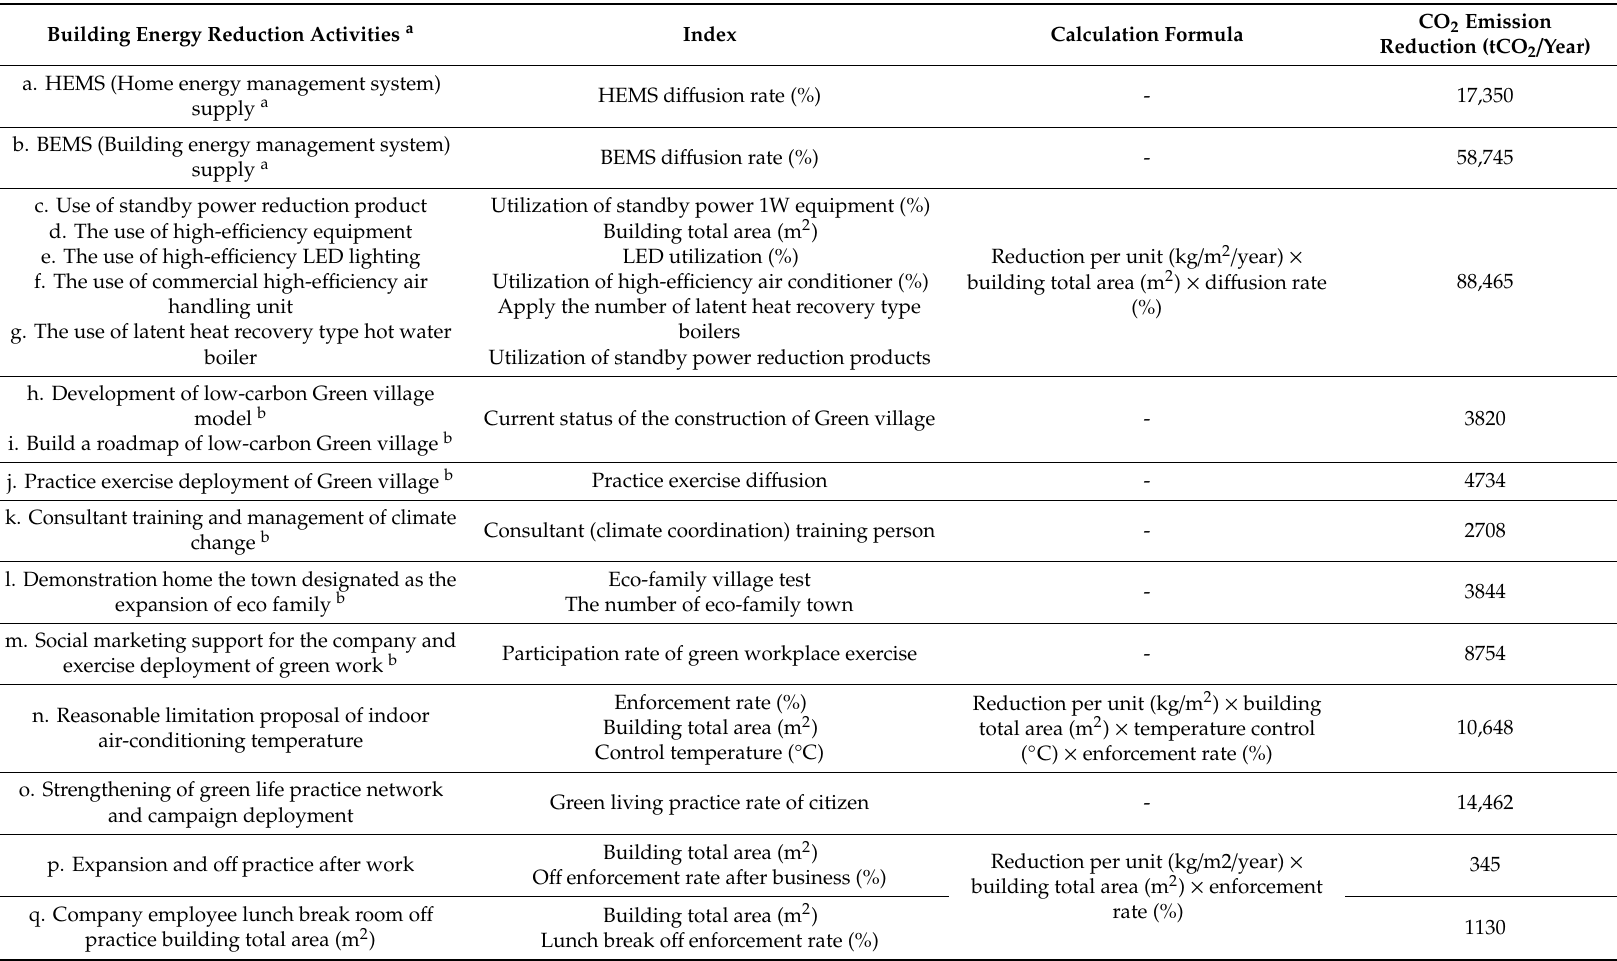
Table 5. Evaluation indicators and the results of the BES